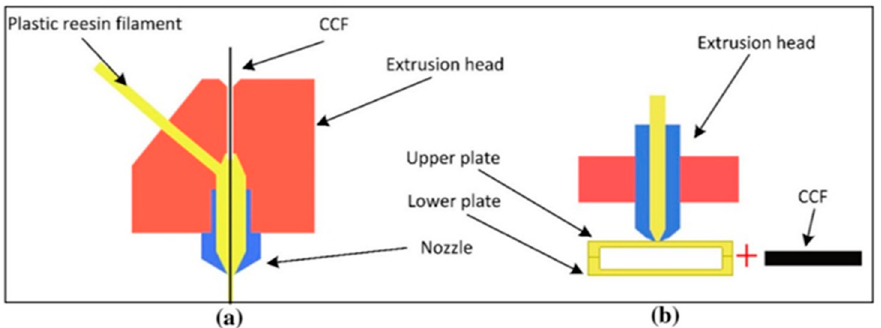
Figure 5. Schematics of in-situ fusion techniques: ( a ) in-nozzle impregnation with polymer and coaxial fibre extrusion, and ( b ) embedding of continuous carbon fibre (CCF) after 3D printing in a thermal bonding process. Images from [42].